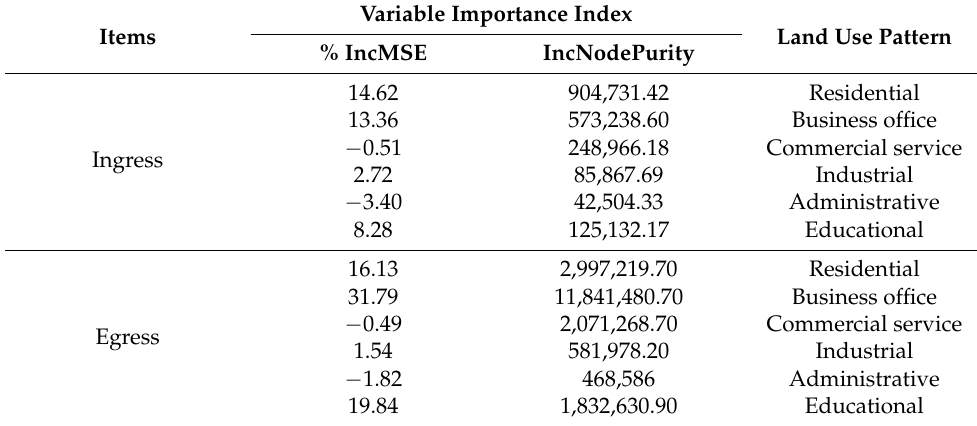
Table 4. Variable importance measuring